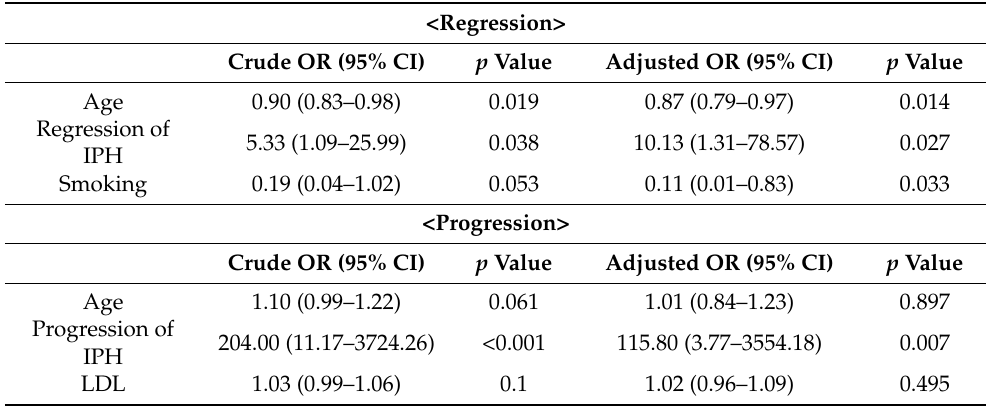
Table 4. Univariate and multivariate analyses of parameters associated with regression and progres- sion of cerebral artery